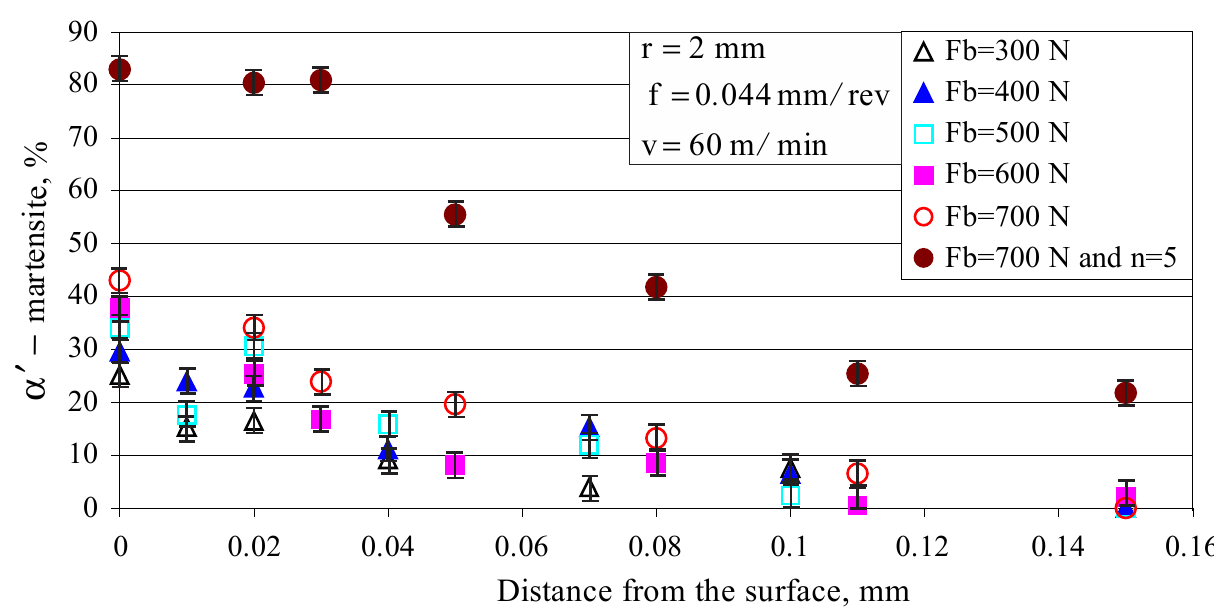
Figure 13. Distribution of the strain-induced martensite in a depth.